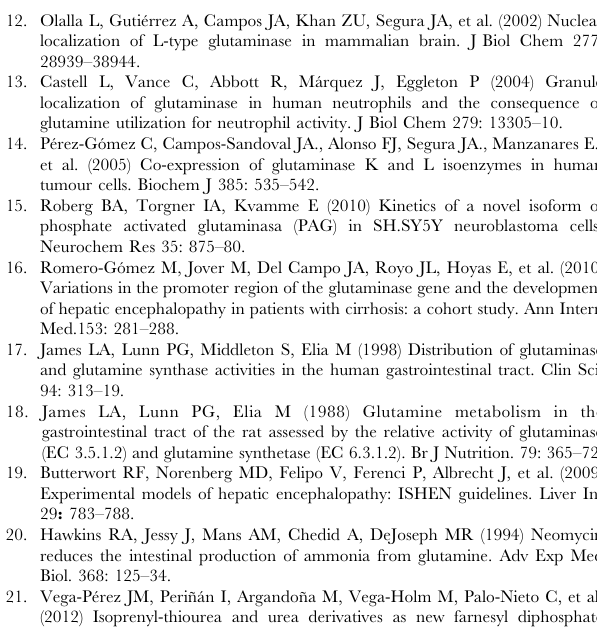
Figure S1 Fasted C57BL/6 mice were treated